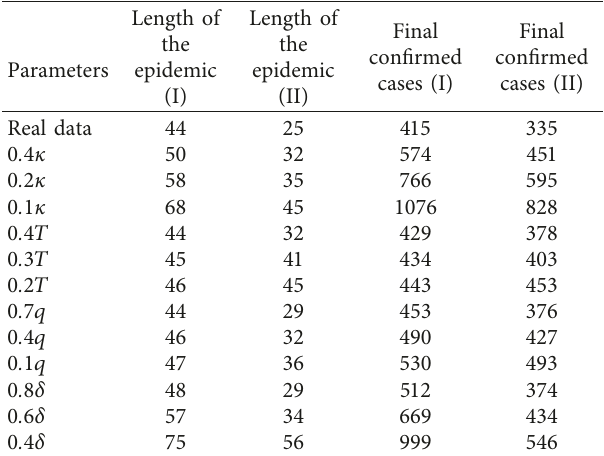
Figure 9: Cumulative number of confirmed cases of the second outbreak in Beijing from 11 June to 3 September, 2020 with various values of contact rate c or progression rate of infectives to hospital δ . Table 2: The impact of media awareness, contact tracing, and confirmation measures on the length of the epidemic and the final number of confirmed